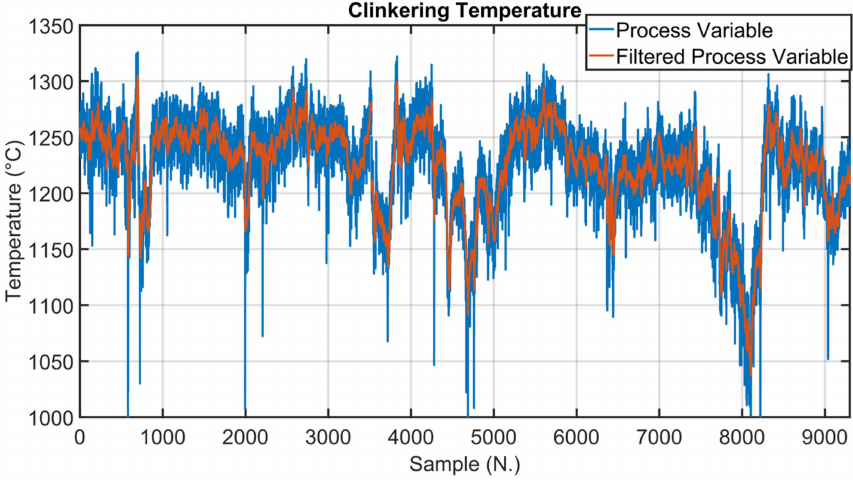
Figure 10. Rotary kiln APC system: data analysis results (clinkering